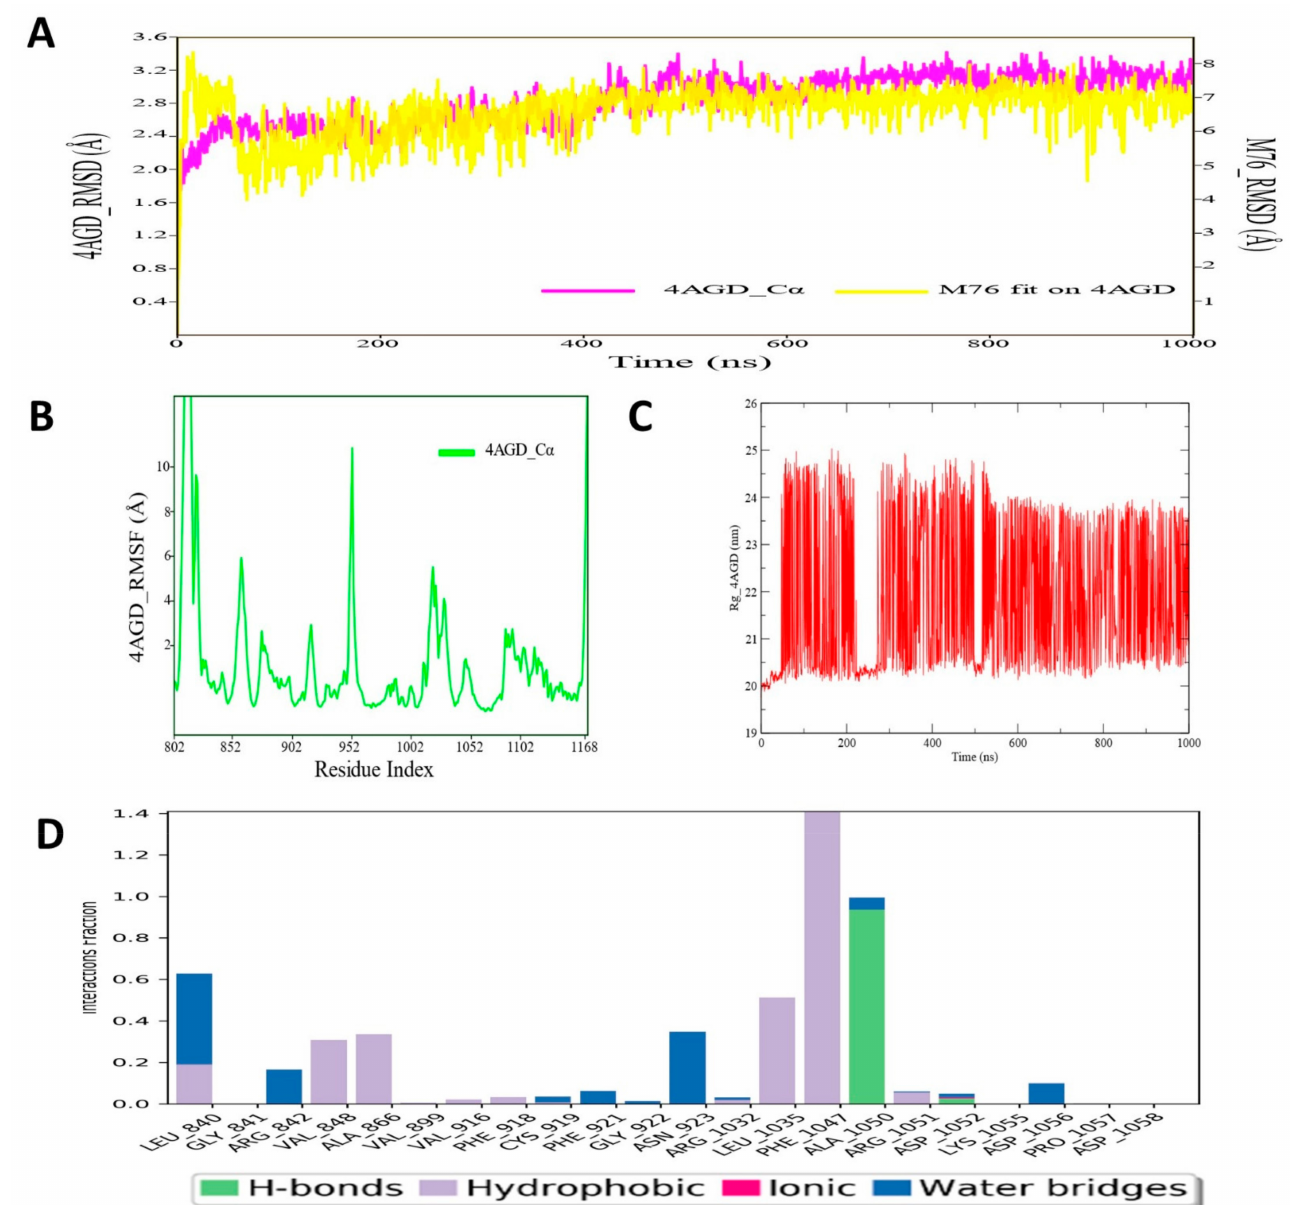
Figure 9. ( A ) RMSD profile of VEGFR (4AGD) protein backbone and compound M76 during 1000 ns simulation; ( B ) RMSF profile of VEGFR (4AGD) protein backbone during 1000 ns simulation; ( C ) RoG profile of VEGFR (4AGD) protein backbone during 1000 ns simulation; ( D ) illustration of the VEGFR (4AGD)–M76 contacts or interactions map monitored during 1000 ns